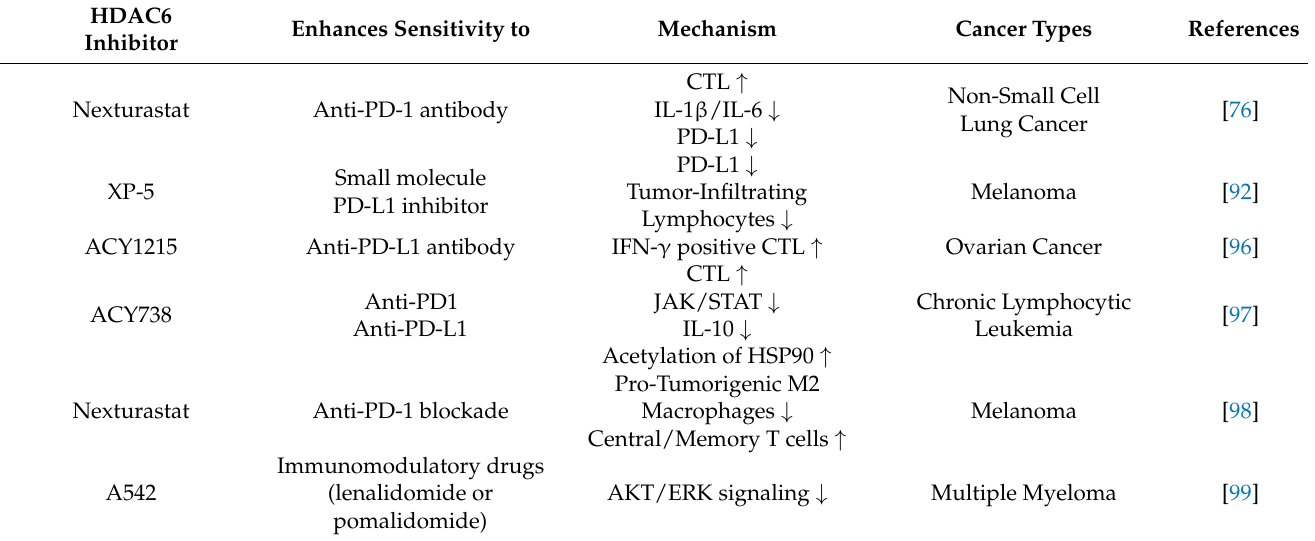
Table 4. Effects of HDAC6-selective inhibitors on sensitivity of cancer cells to immune checkpoint